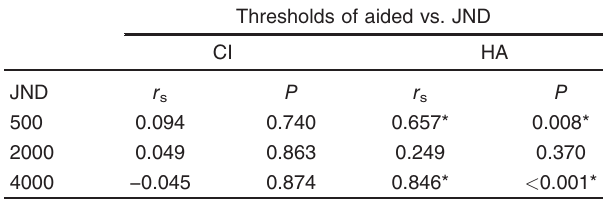
Table 5 Correlation between just noticeable difference and language test